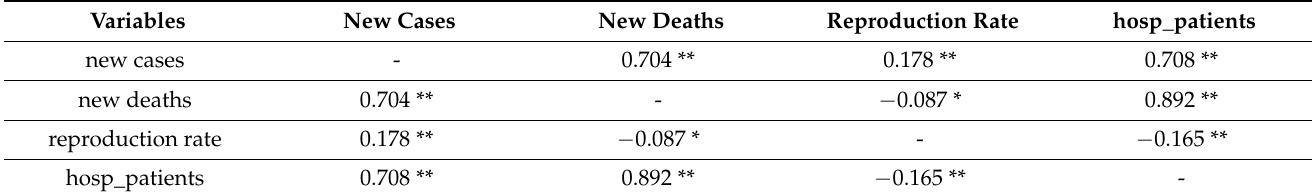
Table A4. Correlations between variables belonging to group Intensity of the disease in Portugal.